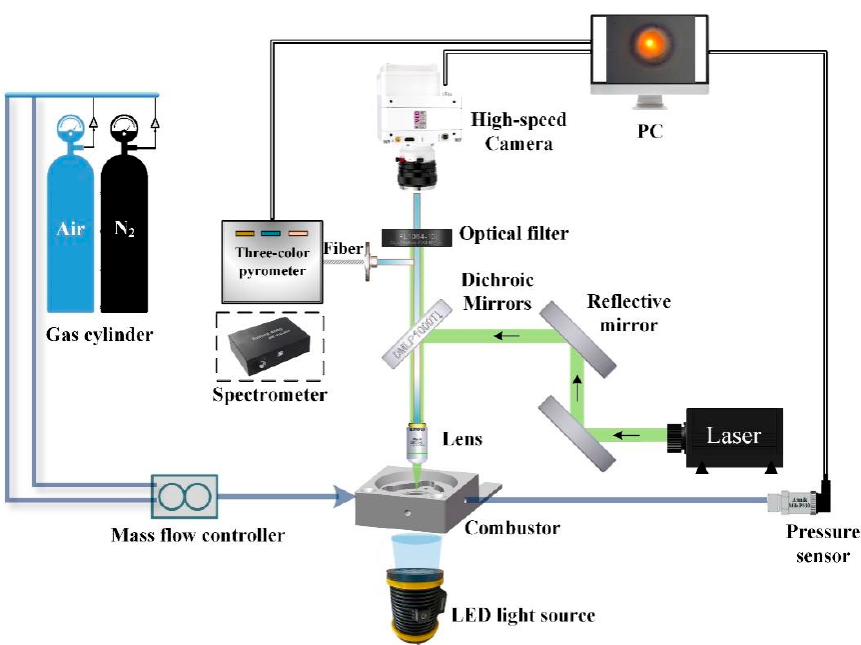
Figure 5. Schematic of experimental setup.